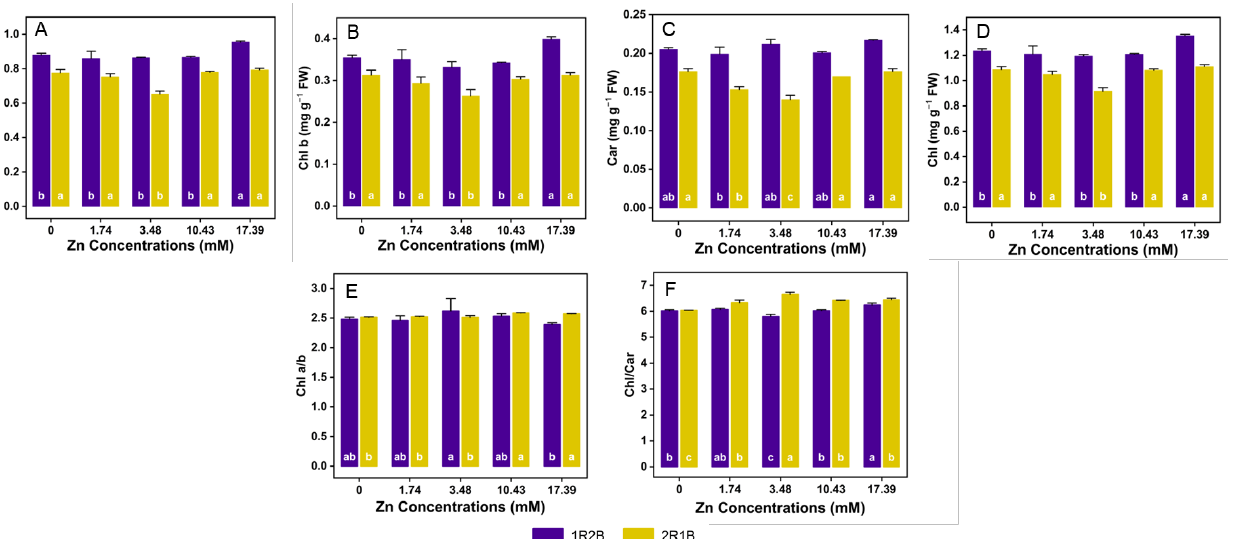
Figure 2. The contents of Chl a ( A ), Chl b ( B ), Car ( C ) and Chl ( D ), Chl a/b ( E ) and Chl/Car ( F ) in flowering Chinese cabbage (FCCS) sprouts grown under combination of Zn concentration and R-B ratio (ratios of red and blue light). The letters marked in all figures indicate the significance of the difference under Zn treatments ( p ≤ 0.05, Duncan’s test). Chl a, Chl b, Chl, Car, Chl a/b and Chl/Car represent chlorophyll a, chlorophyll b, total chlorophyll, carotenoids, ratio of chlorophyll a to chlo- rophyll b and total chlorophyll to carotenoids, respectively. Table 3. The interaction effects on pigment content in flowering Chinese cabbage sprouts (FCCS).